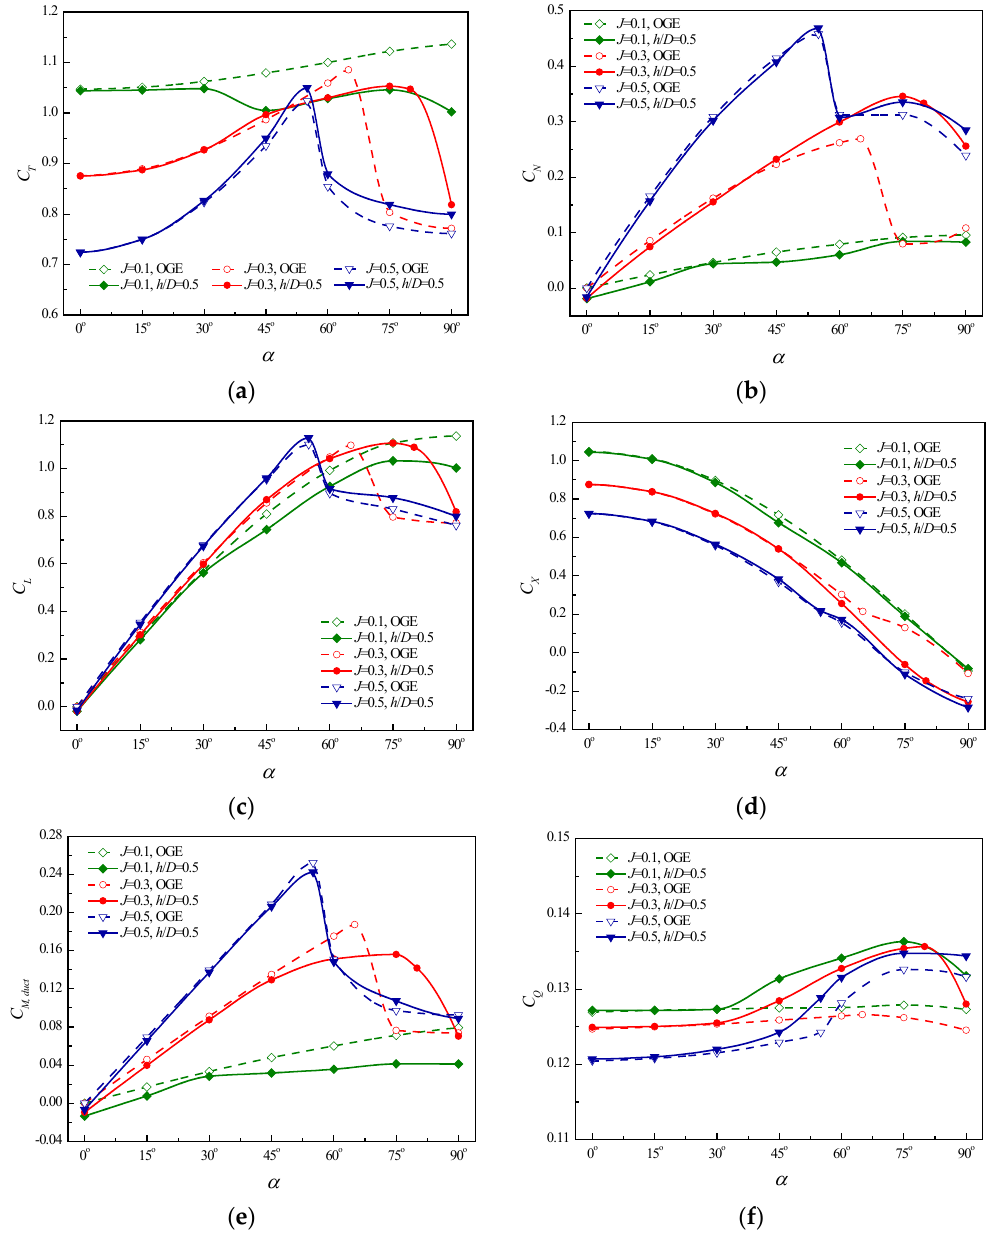
Figure 23. Aerodynamic coefficients at different advance ratios and angles of attack: ( a ) thrust coefficient; ( b ) normal force coefficient; ( c ) lift coefficient; ( d ) propulsive force coefficient; ( e ) pitching moment coefficient of duct; ( f ) torque coefficient.